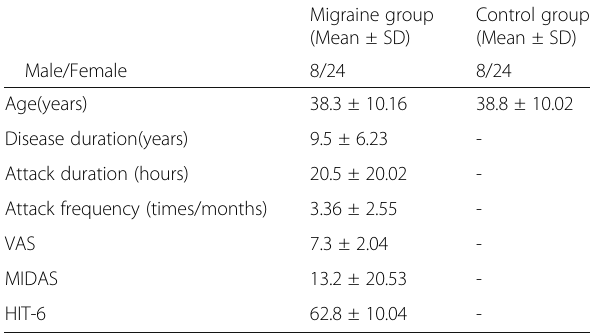
Table 1 Demography and clinical scores of the migraine group and control